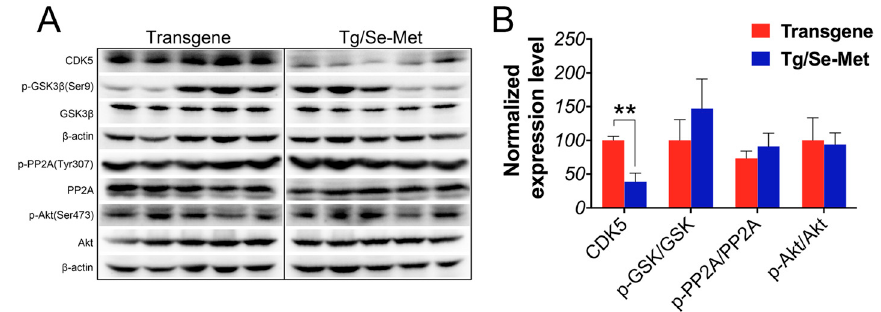
Figure 3. Se-Met treatment reduced the level of CDK5, inhibited the activity of GSK-3 β . ( A ) The level of CDK5, GSK-3 β , phosphorylated GSK-3 β (Ser9), PP2A, phosphorylated PP2A (Tyr307), Akt, and phosphorylated Akt (Ser473) in the OB were detected using western blot; ( B ) Quantitative analysis indicated that the level of CDK-5 significantly decreased in Se-Met-treated mice and that Se-Met could also increase the relative ratio of pGSK-3 β /GSK-3 β with no significant difference. Quantitative results were normalized against the levels of β -actin. Values were expressed as percentages in comparison with the control (set to 100%) and presented as the group mean ± SEM ( n = 5). ** p < 0.01 vs. the control group.